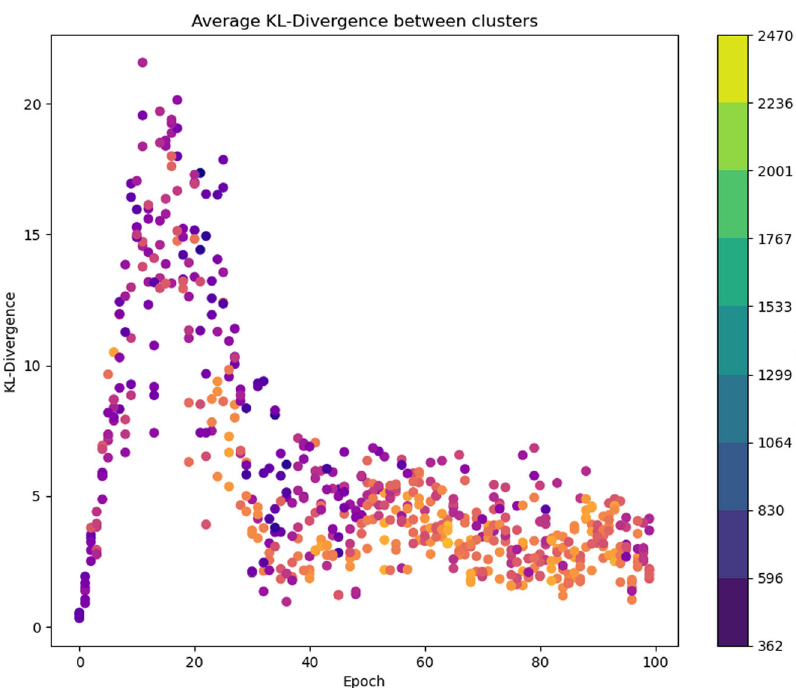
Fig. 5 KL divergence during adversarial agent training. Average reward is represented by the dot color, with lighter being higher